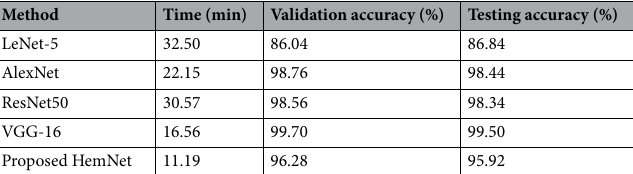
Table 4. Analysis of deep models using time versus classification accuracy on concrete crack